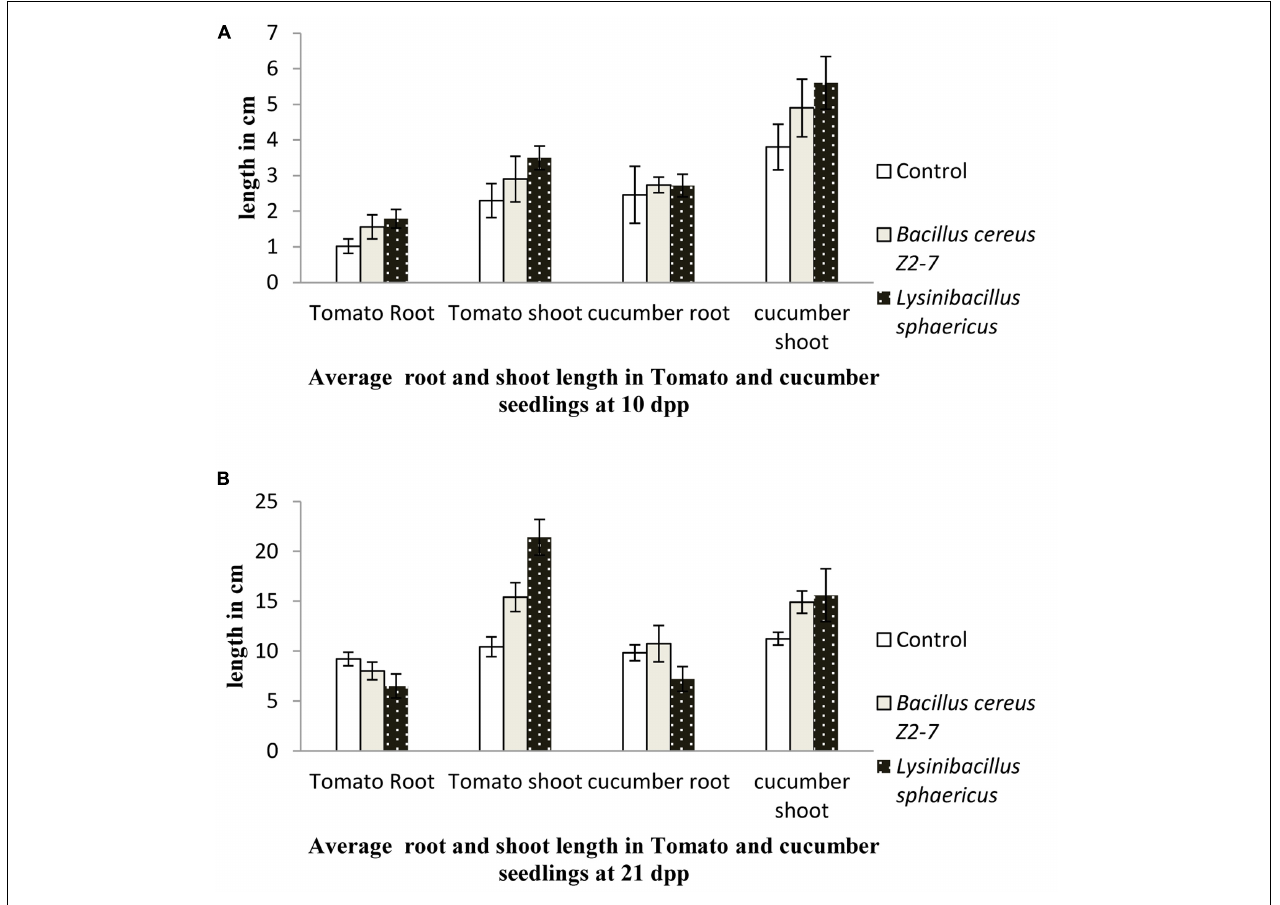
FIGURE 1 | Effect of Lysinibacillus sphaericus on growth of Lycopersicon esculentum (Tomato) and Cucumis sativus (Cucumber) seedlings after 10 days (A) and 21 days (B) as compared to uninoculated control and reference strain Bacillus cereus .